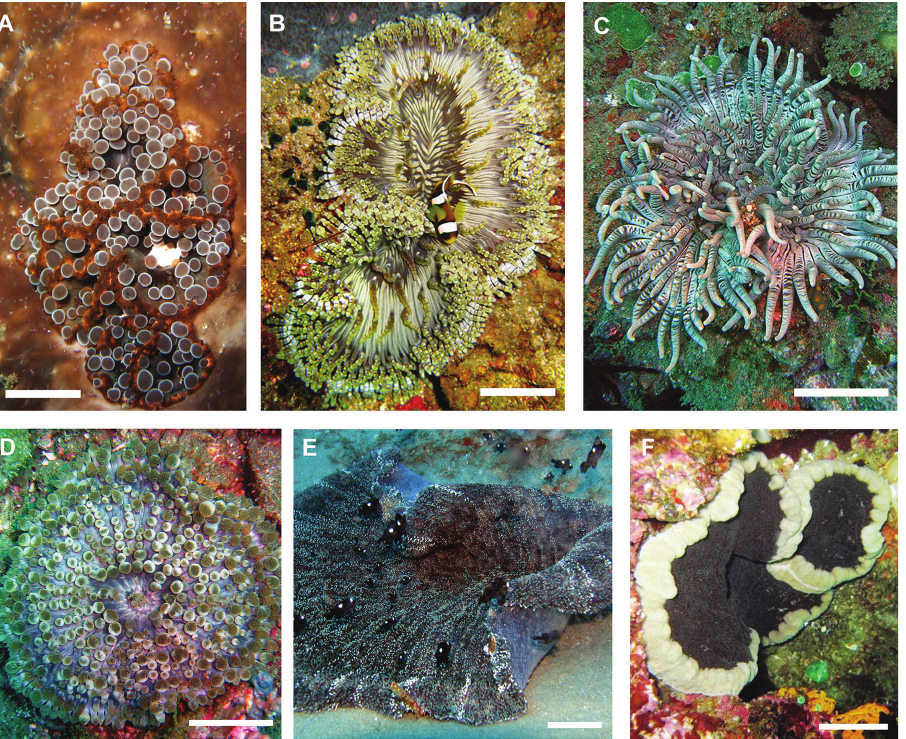
Figure 5. Six of the twelve species recorded from South Africa for the first time: A Triactis producta (30 mm) B Heteractis aurora (50 mm) C Heteractis crispa (50 mm) D Heteractis malu (40 mm) E Stichodac- tyla haddoni (100 mm) and F Cryptodendrum adhaesivum (150 mm). Photographs taken by Dr Megan Laird ( A–C, F ), Christo Van Jaarsveld ( D ) and Dr Kerry Sink ( E Heteractis crispa (Hemprich & Ehrenberg in Ehrenberg, 1834) Fig. 5C